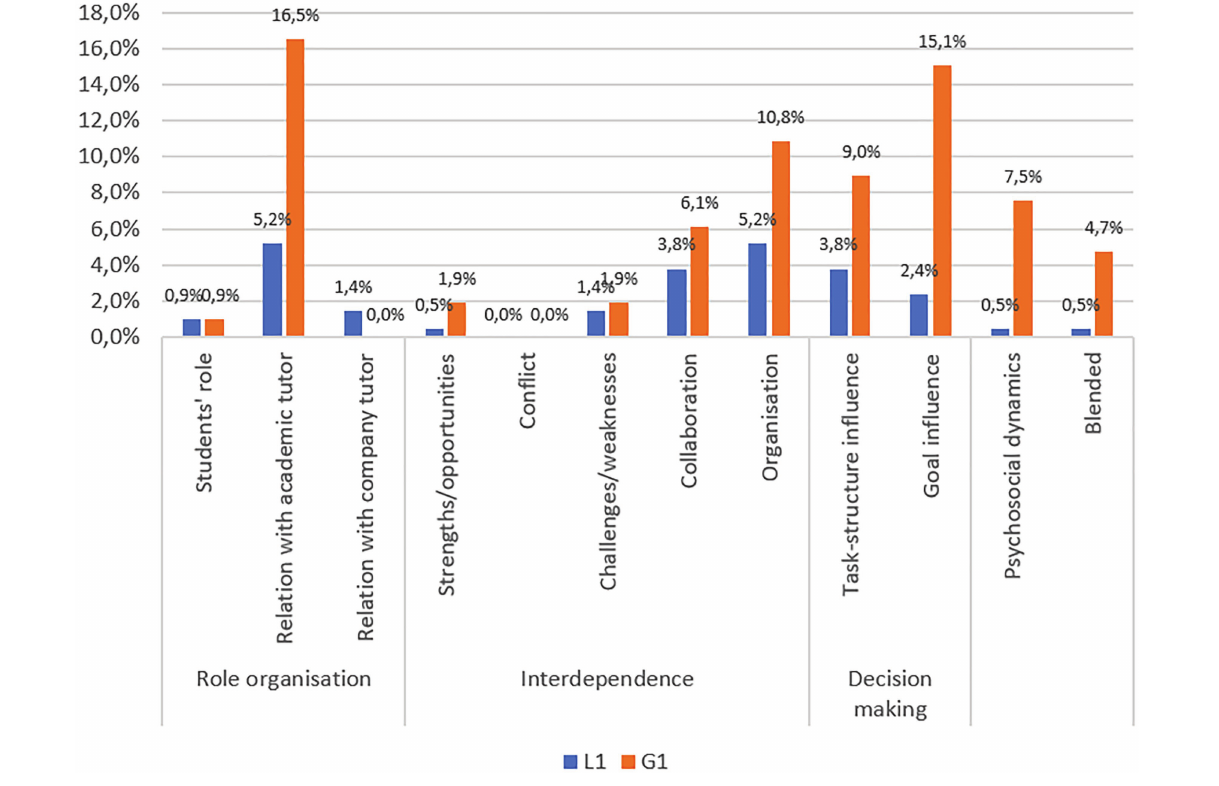
FIGURE 1 | Occurrences in the two chats with only academic tutors